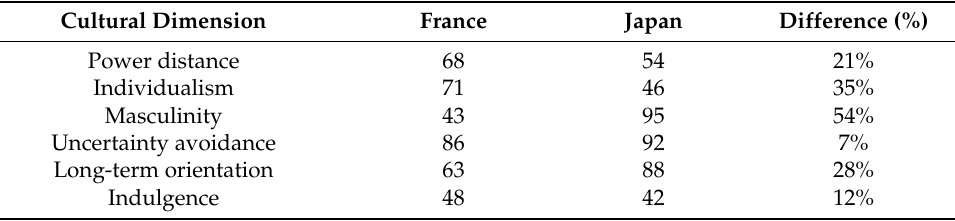
Table 2. Comparison of Hofstede’s cultural values between France and Japan. Cultural Dimension France Japan Difference (%) Power distance 68 54 21% Individualism 71 46 35% Masculinity 43 95 54% Uncertainty avoidance 86 92 7% Long-term orientation 63